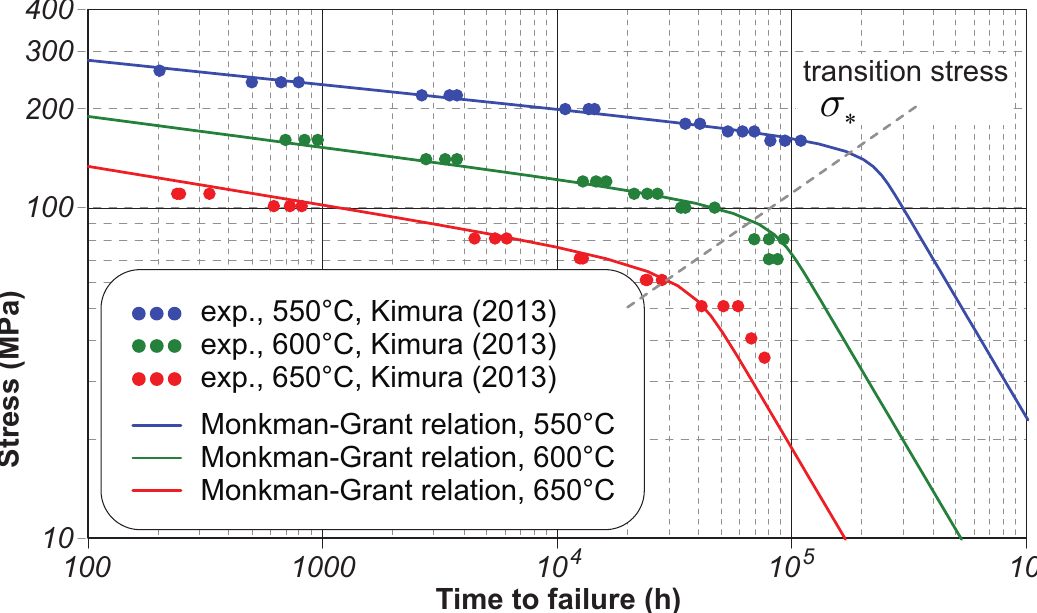
Figure 5: Stress vs. creep rupture life of ASTM P91 steel based on the data by